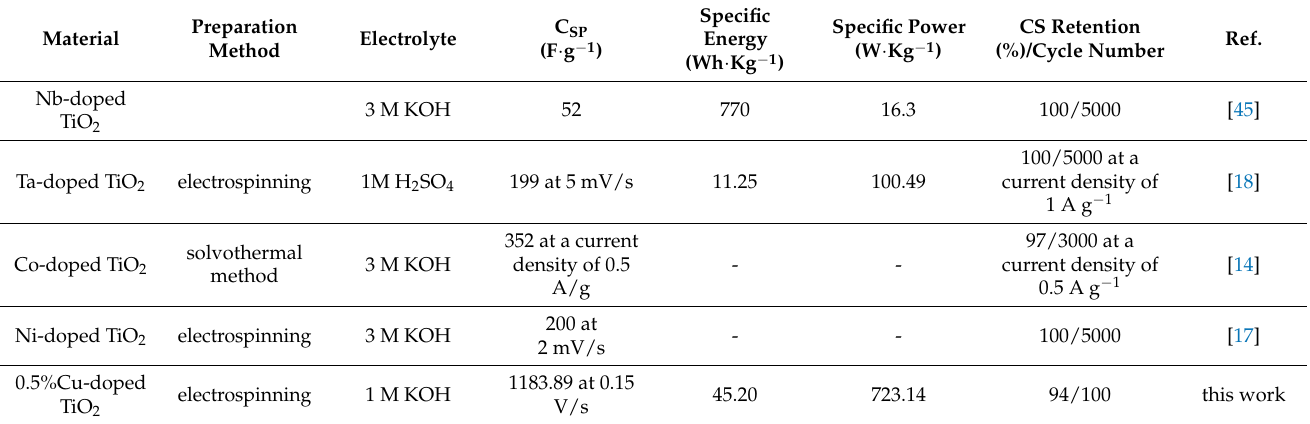
Table 4. A comparison of the electrochemical properties of Cu-doped TiO 2 composites with the properties of other metal-doped TiO 2 systems reported in the literature.